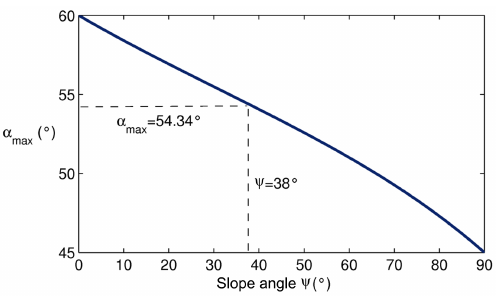
Figure A1. Angle of maximum shear stress α max vs. slope angle ψ